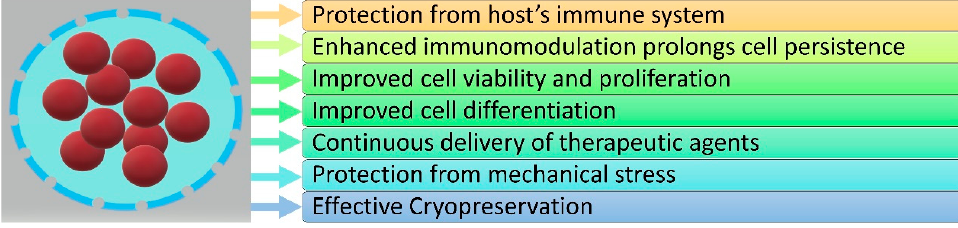
Figure 3. Benefits of stem cell encapsulation.